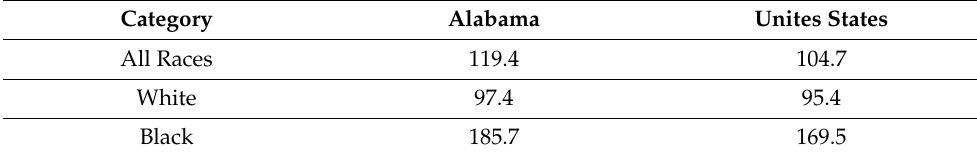
Table 1. Alabama and the United States prostate cancer incidence rates by